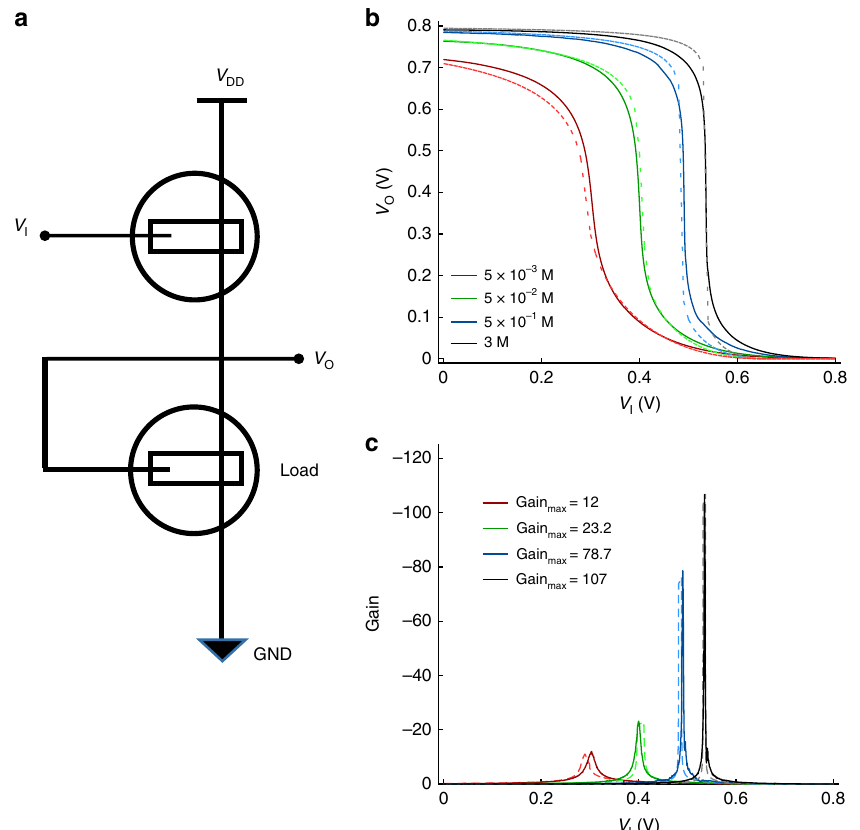
Fig. 8 Unipolar OECT based inverter. a Schematic of the designed circuit. The driver geometries are W = 1000 µ m, L = 500 µ m, t = 210 nm, the load geometries are W = 1000 µ m, L = 500 µ m, t = 280 nm. Crys-P is used for the OECT channel, and details are provided in Supplementary Note 4. b Measured (solid line) and simulated (dashed lines) voltage transfer characteristics of the inverter. c Measured (solid line) and simulated (dashed lines) gain of the